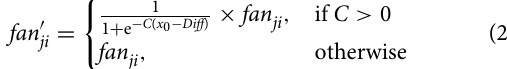
where S is the maximum associative strength parameter ( MAS ), which defaults to